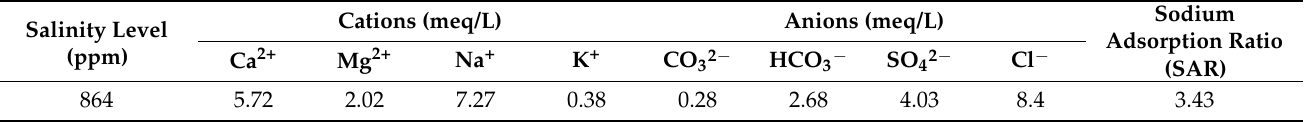
Table 2. Chemical properties and compositions of the irrigation